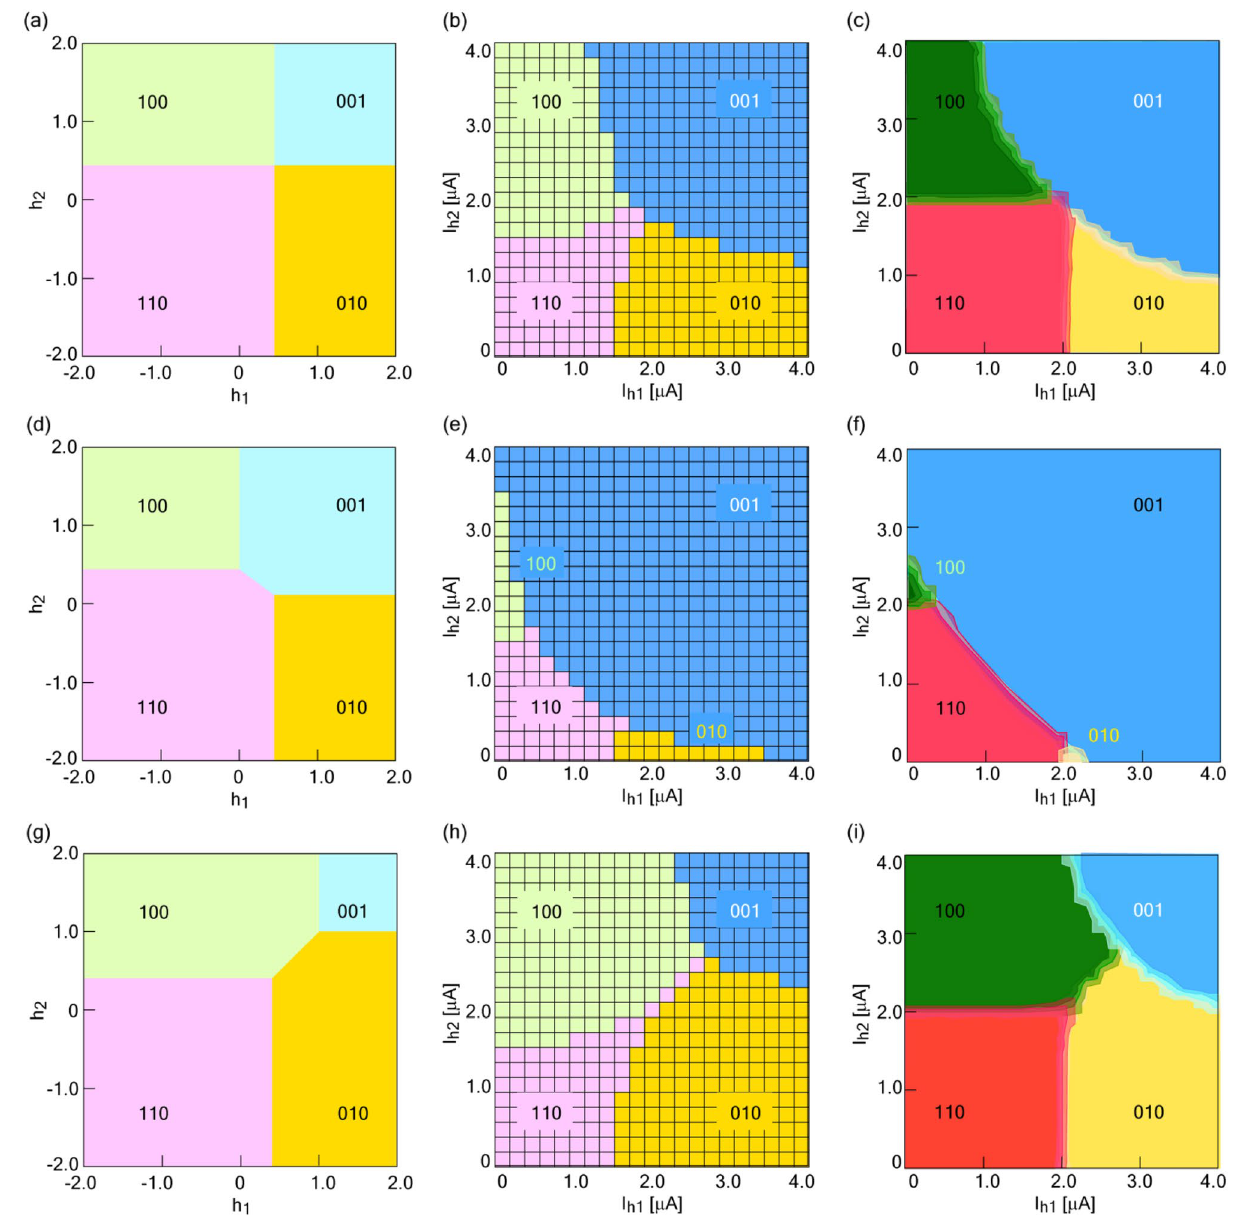
Figure 1. | Trends in state diagrams of NOR operation. State diagrams for ( a-c ) I h3 = 2.0 µA, ( d-f ) I h3 = 1.0 µA, ( g-i ) I h3 = 3.0 µA: ( a , d , f ) theory, ( b , e , h ) JSIM analysis without a thermal noise current, and ( c , f , i ) a 10 mK